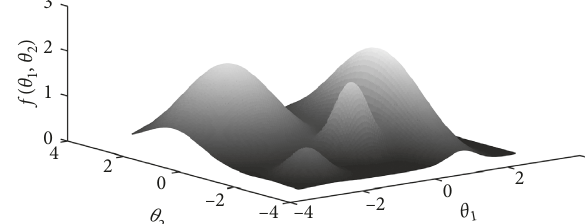
Figure 4: Clustering